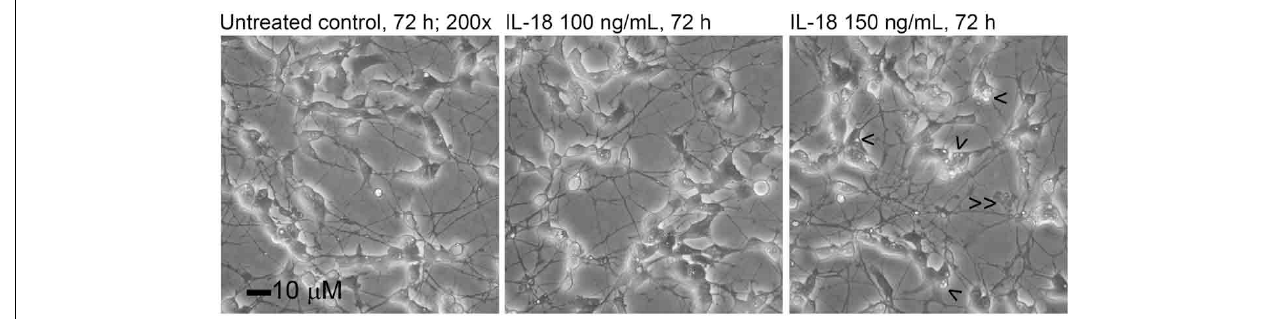
FIGURE 2 | The appearance of the differentiated SH-SY5Y cells treated with 100 or 150ng/ml of IL-18 for 72h. The number of vacuoles ( > ) was higher in 150ng/ml treated cells (about 4.1/ cell) than in untreated control (2.4/ cell) or 100ng/ml treated cells (3.5/ cell). Some cell debris is also apparent ( >> ).